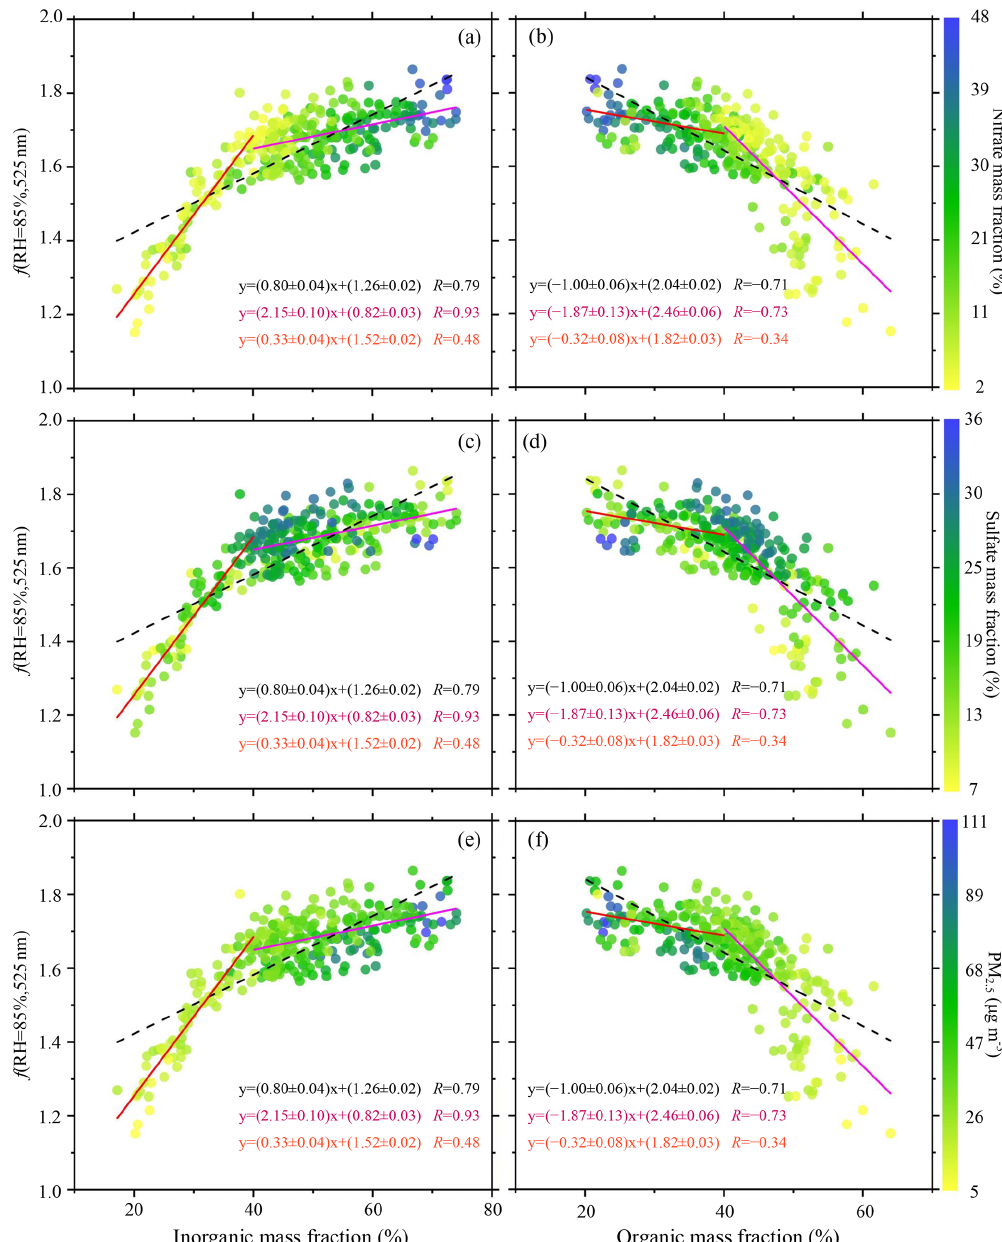
Figure 4. The particle light scattering enhancement factor f (RH = 85%, 525nm) as a function of organic matter mass fraction and inorganic matter mass fraction measured by the ACSM and the AE33: f (RH = 85%, 525nm) as a function of (a) inorganic matter mass fraction and (b) organic matter mass fraction colored by the nitrate mass fraction; f (RH = 85%, 525nm) as a function of (c) inorganic matter mass fraction and (d) organic matter mass fraction colored by the sulfate mass fraction; and f (RH = 85%, 525nm) as a function of (e) inorganic matter mass fraction and (f) organic matter mass fraction colored by the mass concentration of PM 2 . 5 . Dotted black lines denote bivariate linear regressions. The red and magenta lines are the best-fit linear regression lines through data points associated with mass fractions smaller than 40% and larger than 40%, respectively. The linear regression functions and the Pearson’s correlation coefficients ( R ) are given in each